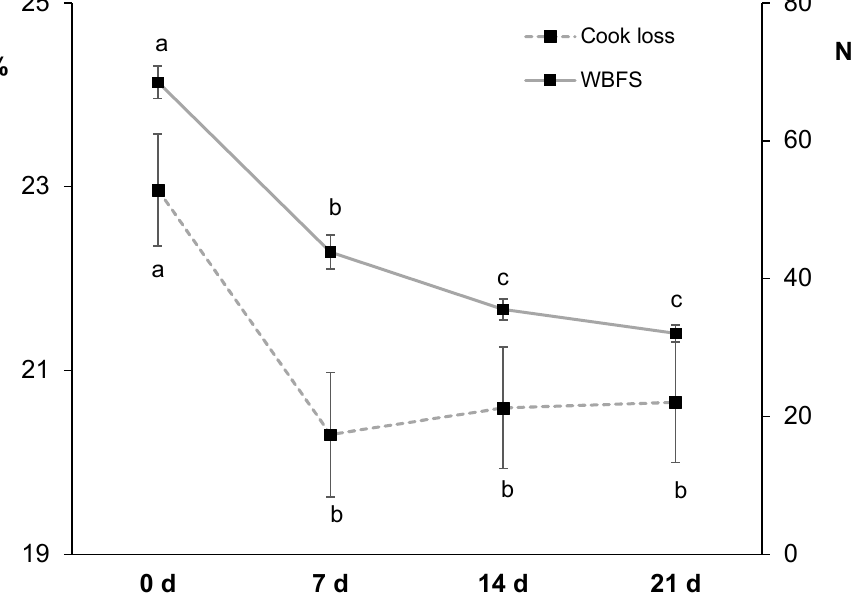
Figure 4. Effect of ageing time (0, 7, 14 and 21 days) on cook loss (left axis) and Warner-Bratzler shear force (WBSF; right axis) in horse longissimus thoracis and lumborum muscle ( n = 20). Different letters indicate statistically significant differences ( p ≤ 0.05).